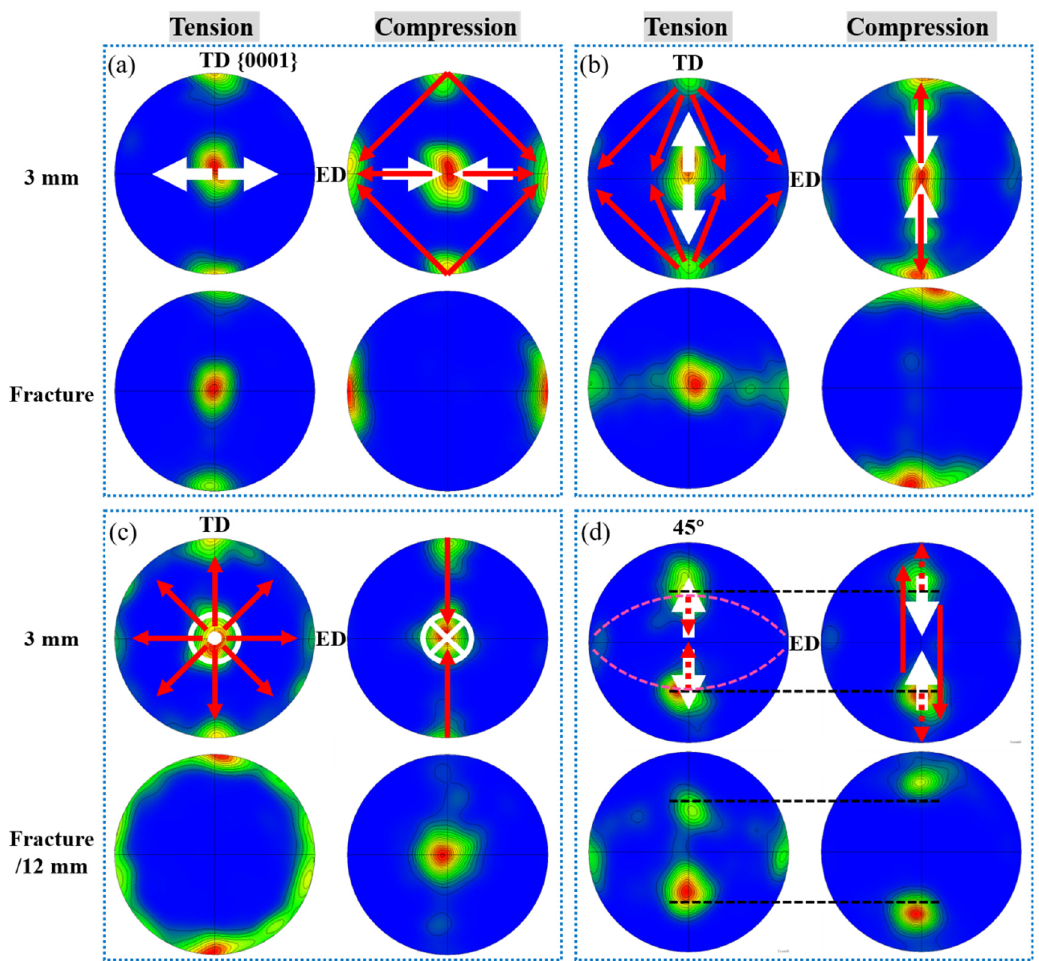
Figure 11. Texture evolution at the tension and compression side of the bar when bent to a displace- ment of 3 mm and fracture/12 mm along ( a ) ED, ( b ) TD, ( c ) TTD, and ( d ) 45°